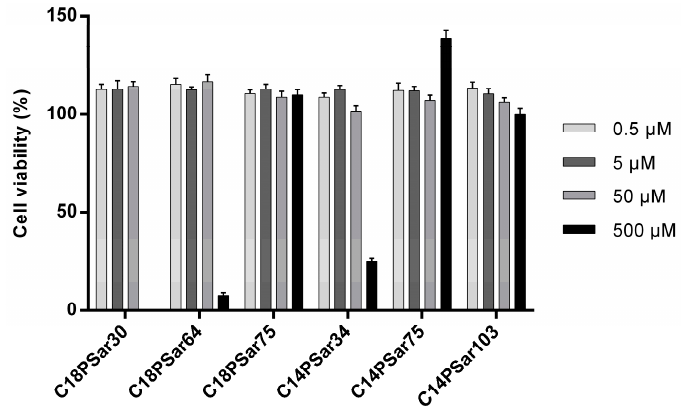
Figure 4. CellTiter-Glo ® (CTG) assay toxicity studies of unformulated amphiphilic PSars in HeLa cells in the concentration range from 0.5 up to 500 µ M. Data was normalized to the untreated control. For better comparability molar concentrations were chosen. 1.2 mg/mL (C 18 PSar 30 ) and 4.2 mg/mL (C 14 PSar 103 ) correspond to 500 μ mol.